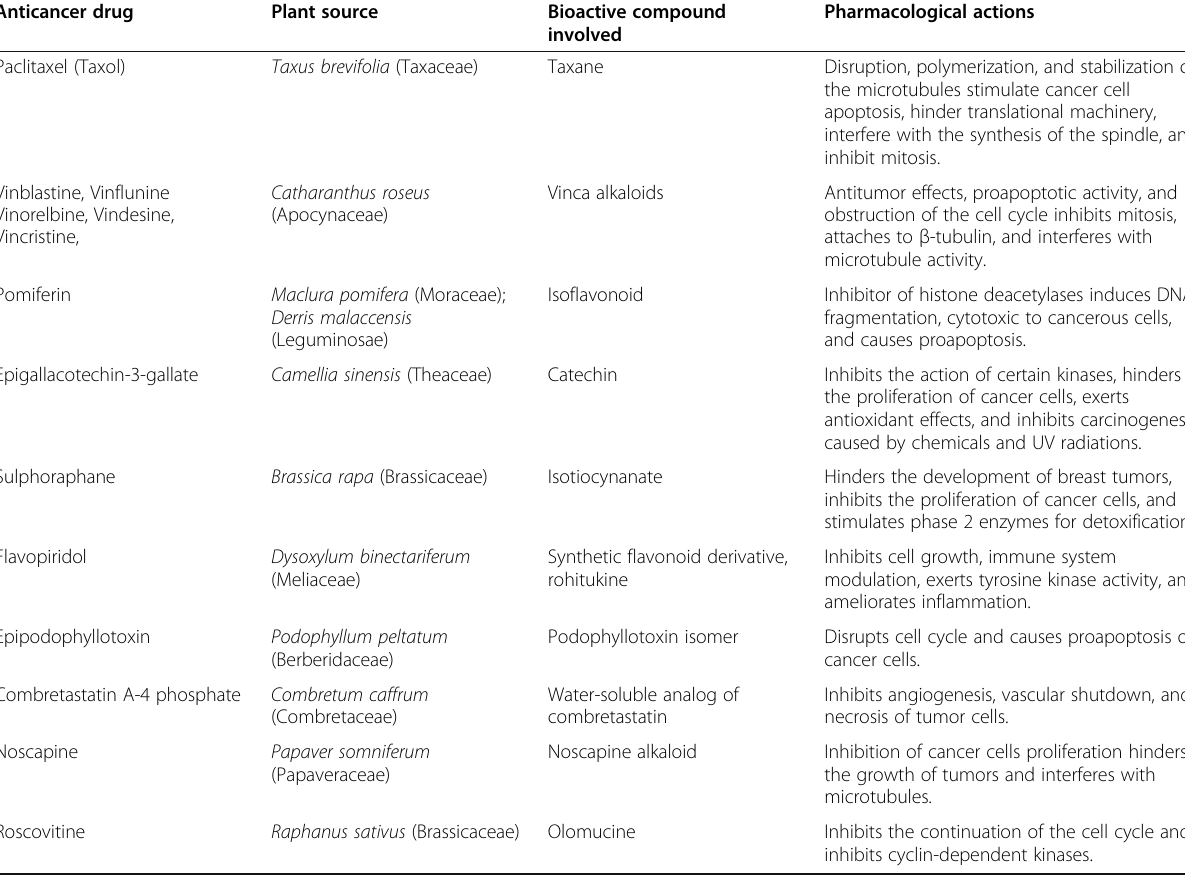
Table 2 Anticancer drugs derived from Nigerian medicinal plants after undergoing research and clinical trials Anticancer